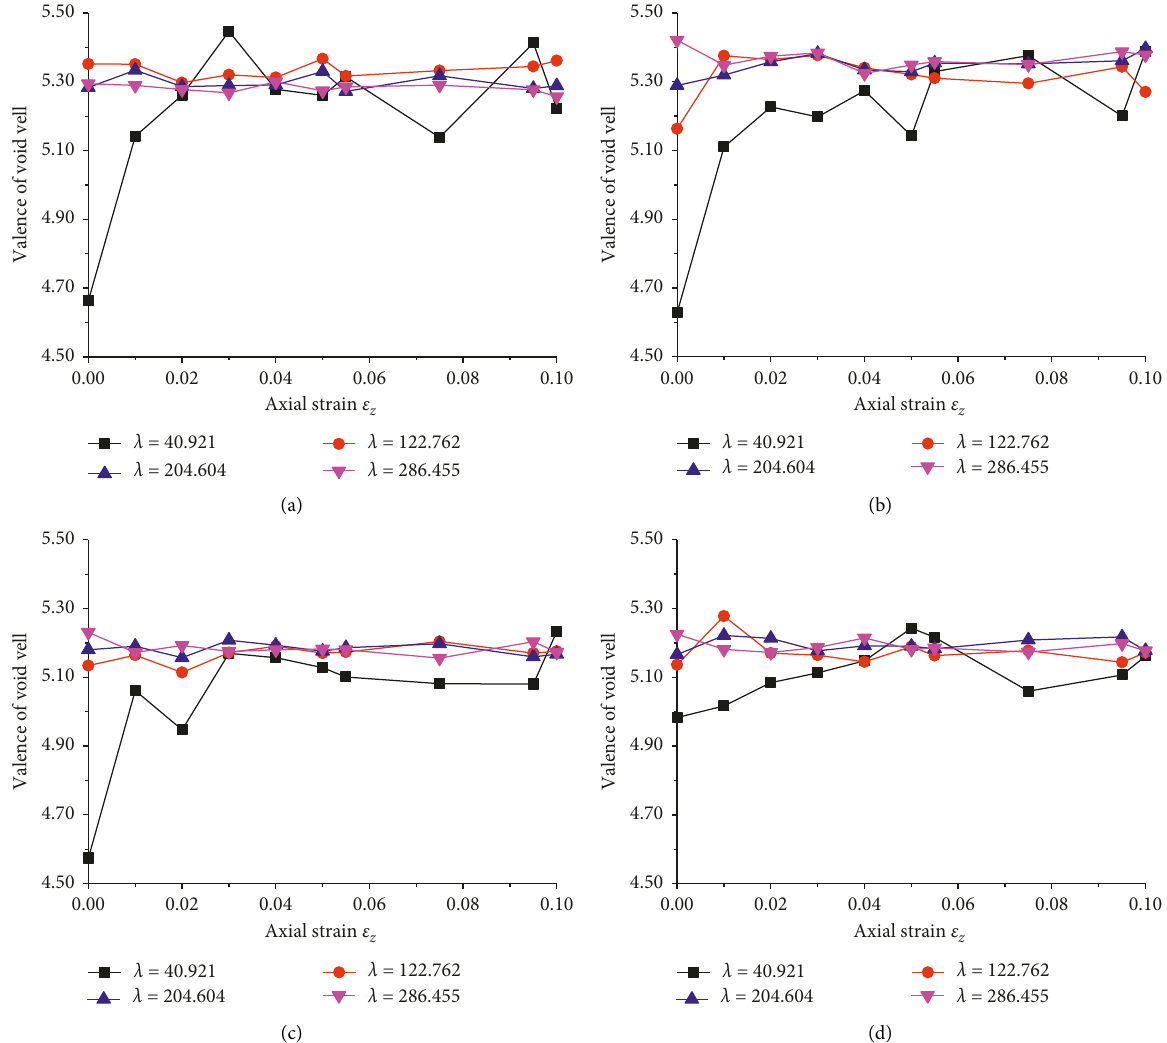
Figure 11: Evolution of valence of void cell in RVEs with various heights and particle sizes. (a) RVEs with various heights at 0g. (b) RVEs with various particle sizes at 0g. (c) RVEs with various heights at 5g. (d) RVEs with various particle sizes at